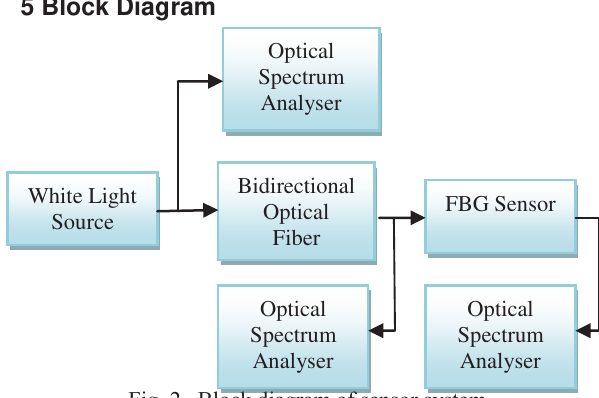
Fig. 2. Block diagram of sensor